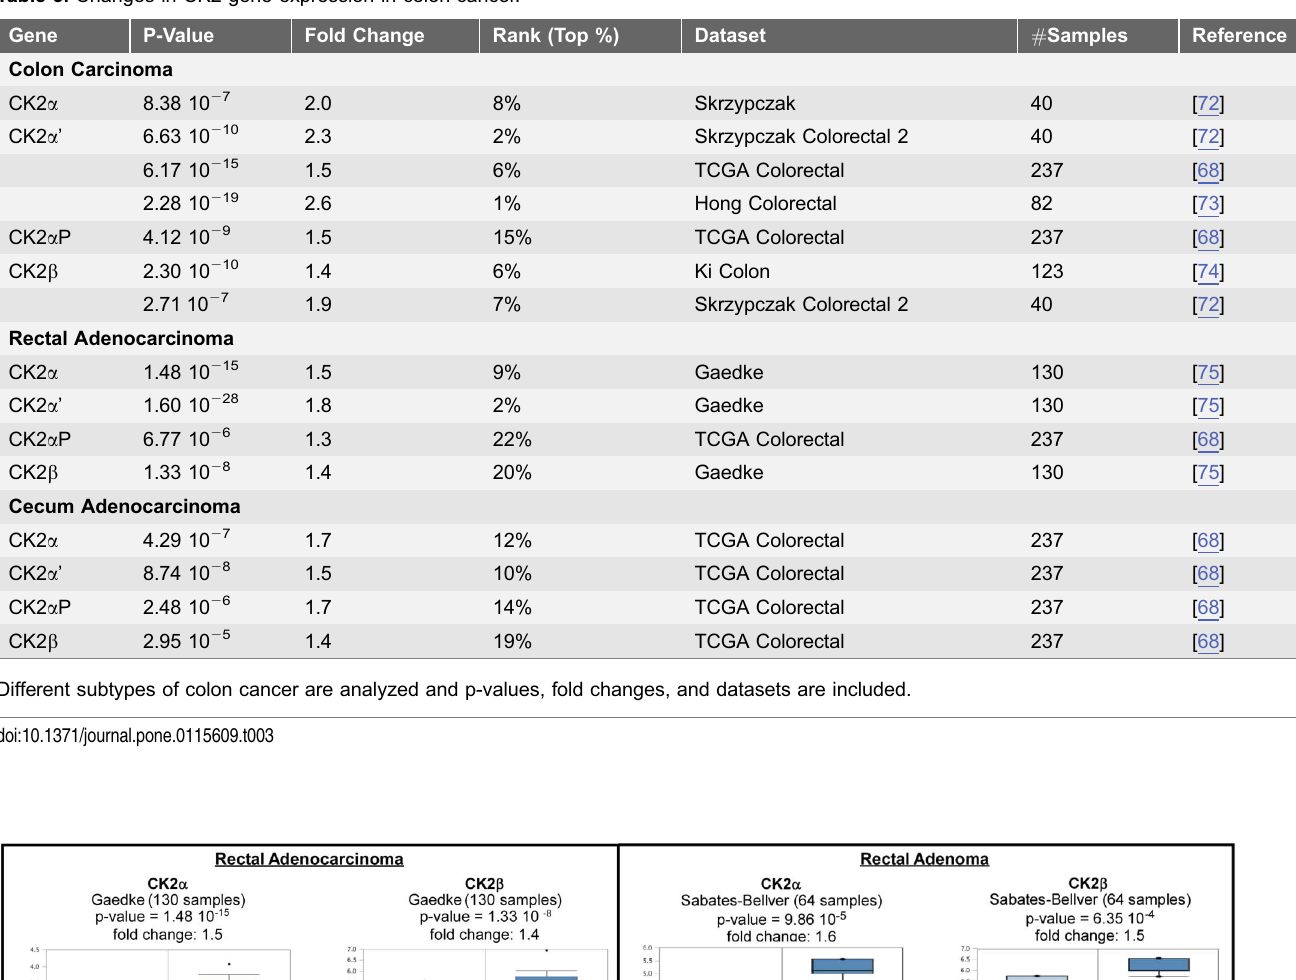
Table 3. Changes in CK2 gene expression in colon cancer.